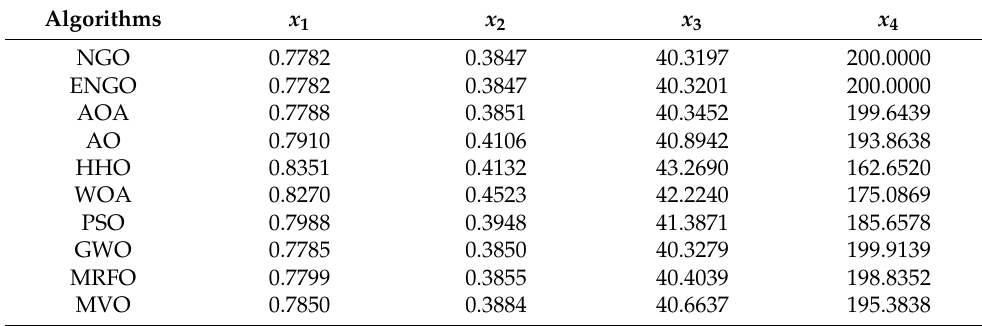
Table 5. The best solution of the gear train design problem obtained by the different algorithms.